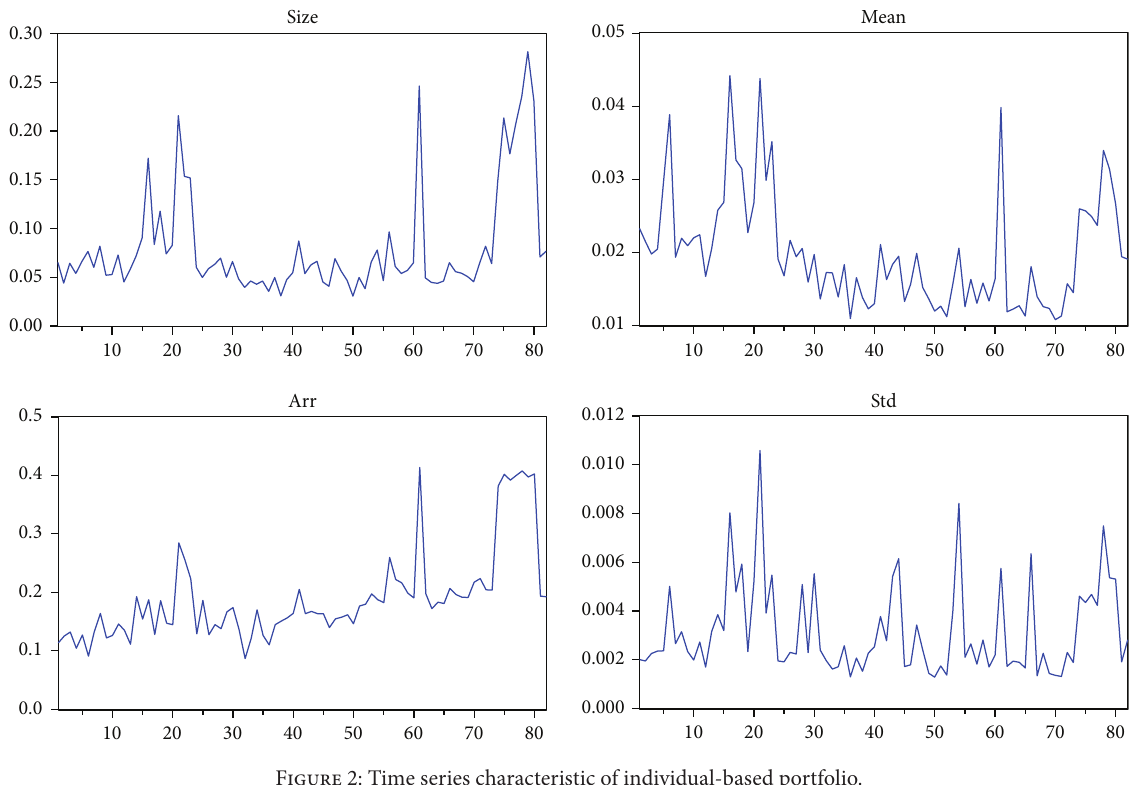
Figure 2: Time series characteristic of individual-based portfolio.